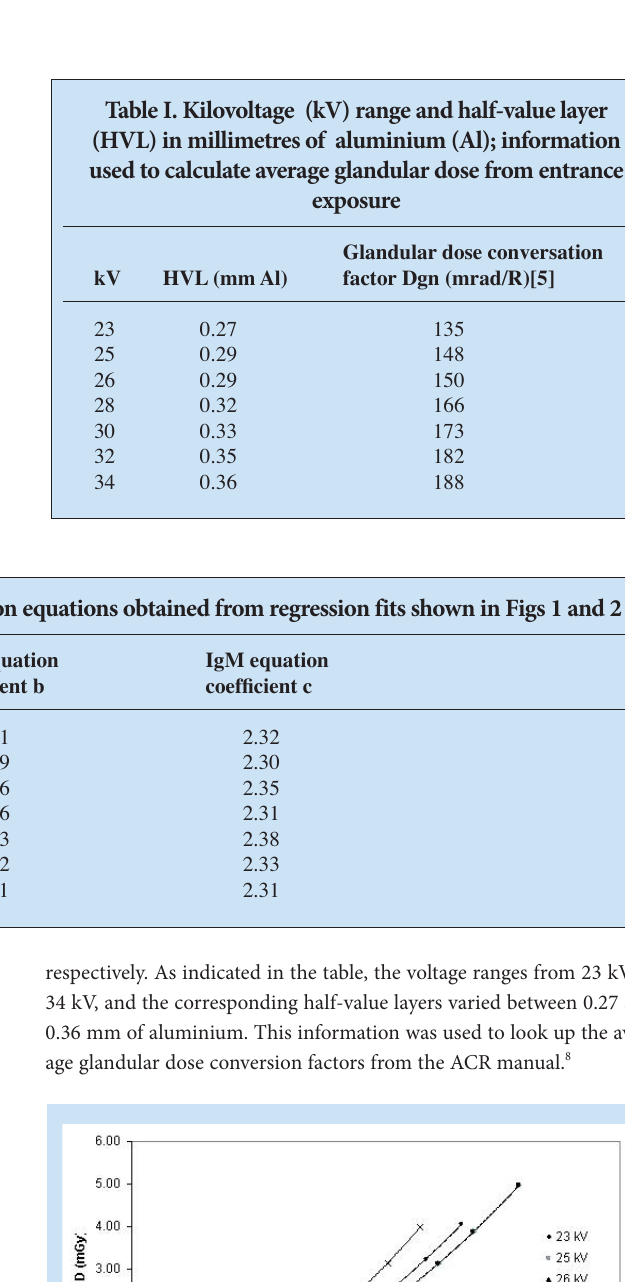
Computed radiography.indd